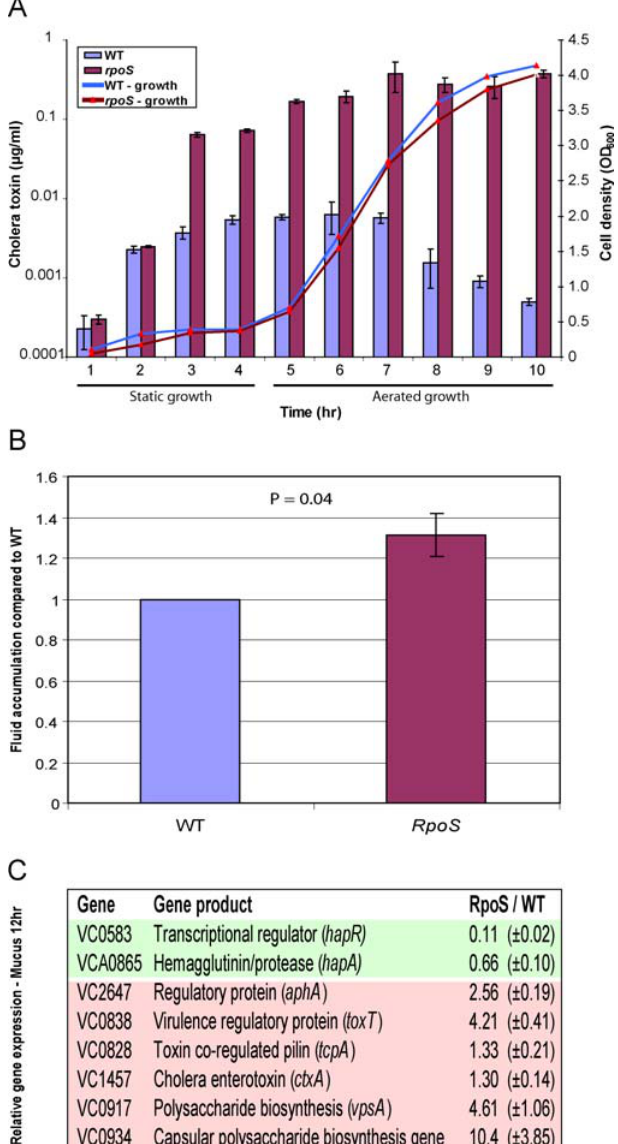
Figure 6. Role of RpoS in the Expression of Virulence-Associated Genes In Vitro and In Vivo (A) CT production during AKI growth conditions. Bacterial growth and CT concentration were measured for wild-type V. cholerae (blue) bacteria and for the V. cholerae rpoS deletion mutant (red) during growth in AKI medium [46]. The cultures were kept static during the first 4 h of the experiment followed by aerobic growth with shaking during the rest of the experiment. Cell density is shown with solid lines, and CT concentrations are shown with bars plotted on a logarithmic scale. (B) Fluid accumulation in the rabbit ileal loop model was compared between neighboring loops inoculated with either wild-type V. cholerae or the rpoS deletion mutant. The graph shows the average fluid accumulation of the rpoS mutant when compared with the neighboring wild-type strain in four pairs of loops from three different rabbits. The variance of the individual ratios is indicated on the graph. Paired one- tailed Students t -test with a significance level of 0.05 was used to ascertain the level of significance of the increased fluid accumulation of the rpoS mutant in the neighboring pairs of loops. (C) Real-time RT-PCR assessment of relative expression levels of selected virulence-associated genes, regulators of virulence gene expression, and genes involved in production of the extracellular polysaccharide in bacteria isolated from rabbit ileal mucus 12 h